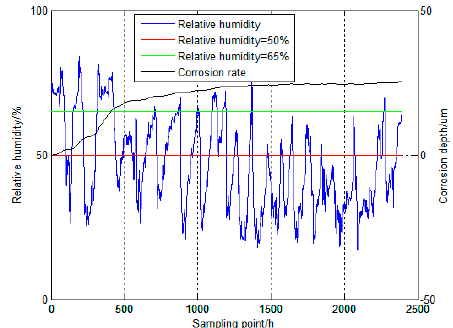
Figure 8. Detailed information about corrosion depth and RH.